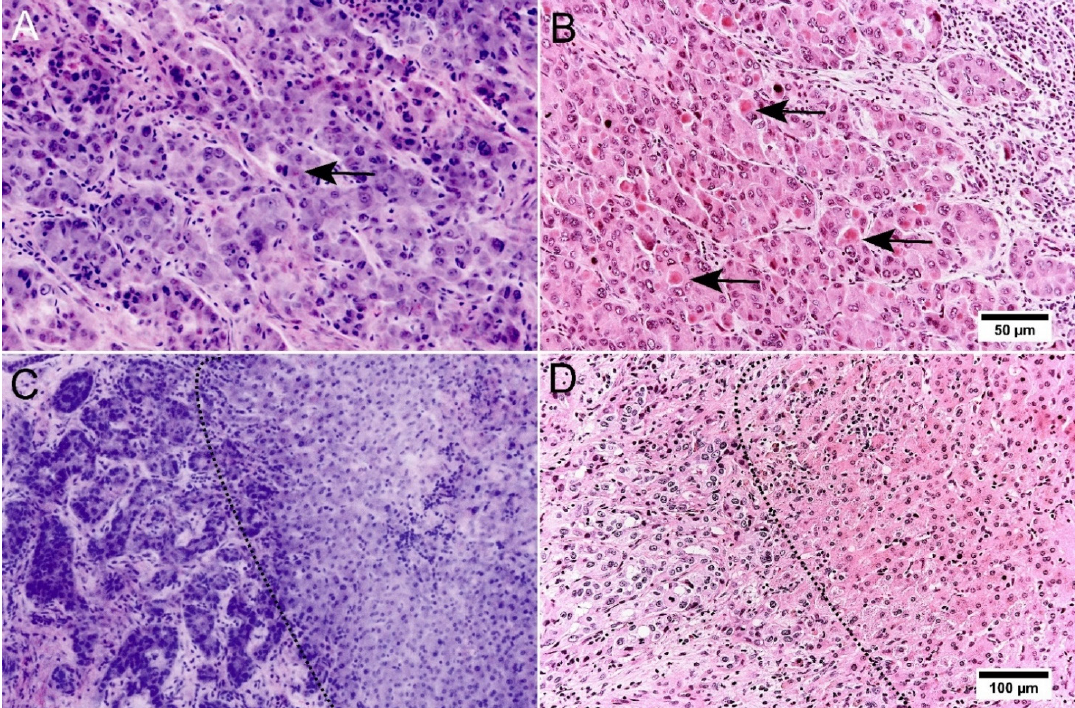
Figure 2. Representation of malignant primary tumors of the liver in FCM scans. ( A , B ): Hepatocellular carcinoma (grade 2) in FCM ( A ) and conventional histology (( B ), HE staining). Infiltrative growth and trabecular architecture were easily recognizable in FCM scans. Note the missing representation of Mallory bodies (arrows) in the FCM scans in comparison to the HE-slide. ( C , D ): Intrahepatic cholangiocellular carcinoma of the liver in FCM ( C ) and conventional histology (( D ), HE staining). Infiltrating groups of neoplastic glands were reliably recognizable in FCM. The dashed line marks the invasion front between tumor formations ( left ) and pre-existing liver parenchyma ( right ).